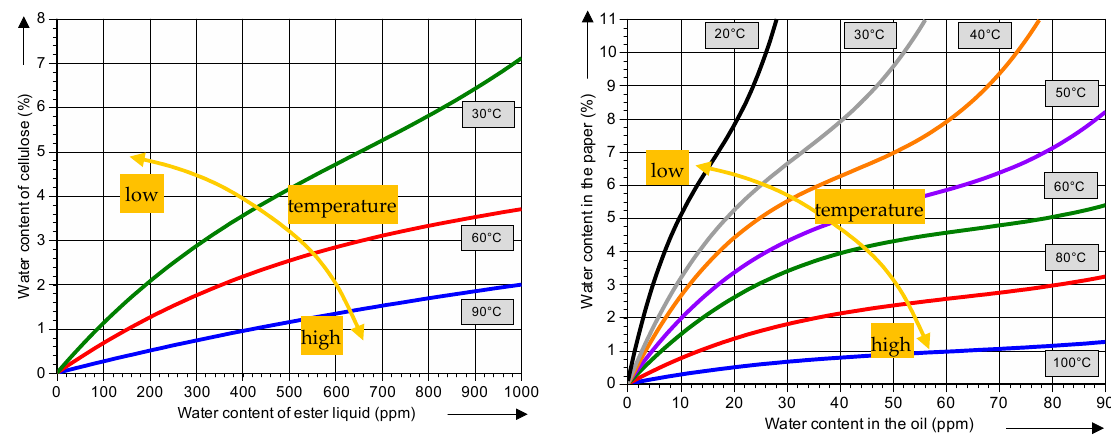
Figure 2. Equilibrium curves for moisture partition between oil and paper (ppm vs. water content of paper) [31].